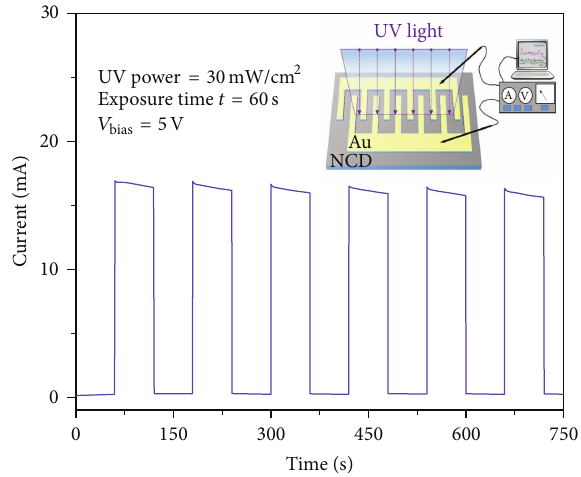
Figure 7: Photocurrent as a function of time measured by switching on and off UV irradiation on the as-fabricated NCD/Au UV